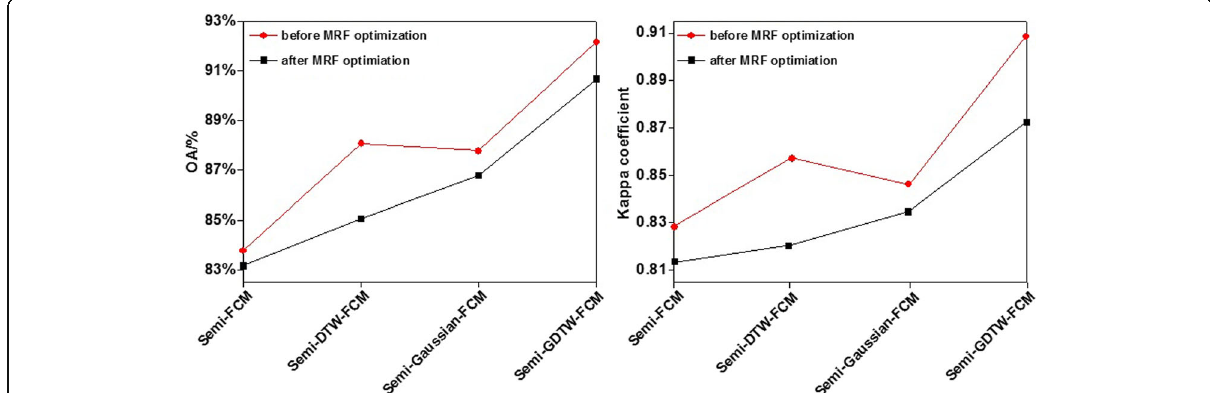
Fig. 5 Comparison of clustering accuracy before and after MRF spatial structure